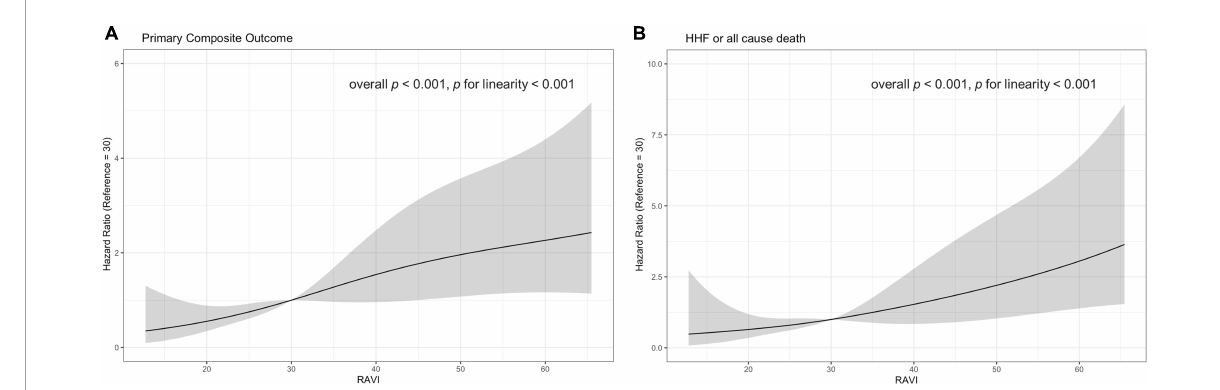
FIGURE4 Estimated hazard ratio with RAVI and (A) primary composite outcome (B) a composite outcome of HHF or all cause death. The solid curves indicating unadjusted estimates and colored curves indicating 95% confidence limits. HHF, hospitalization for heart failure; RAVI, right atrial volume index.